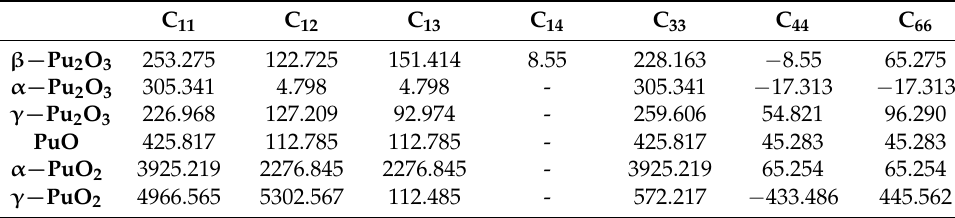
Table 2. Values of mechanical constants C ij of each lead oxide.